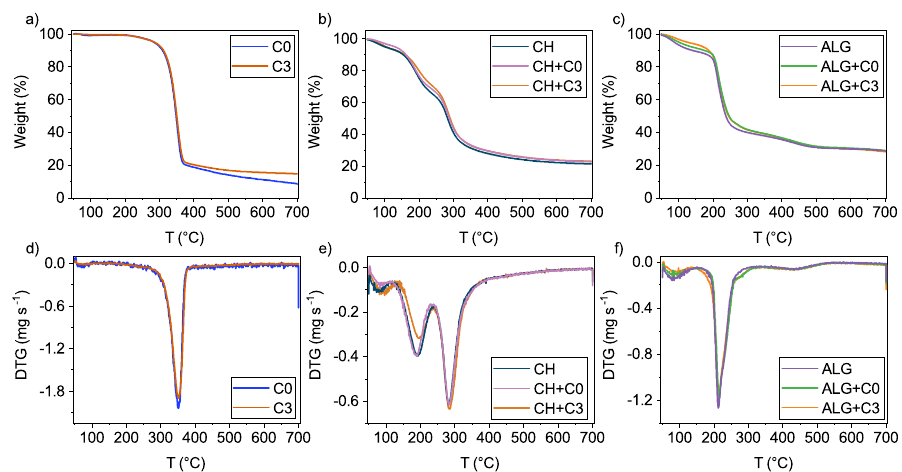
Figure 8. Thermal stability of ( a ) pristine and modified CNCs, ( b ) chitosan-based films (samples CH, CH+C0, CH+C3), and ( c ) alginate-based films (samples ALG, ALG+C0, ALG+C3) and derivates of their weight loss ( d – f ),